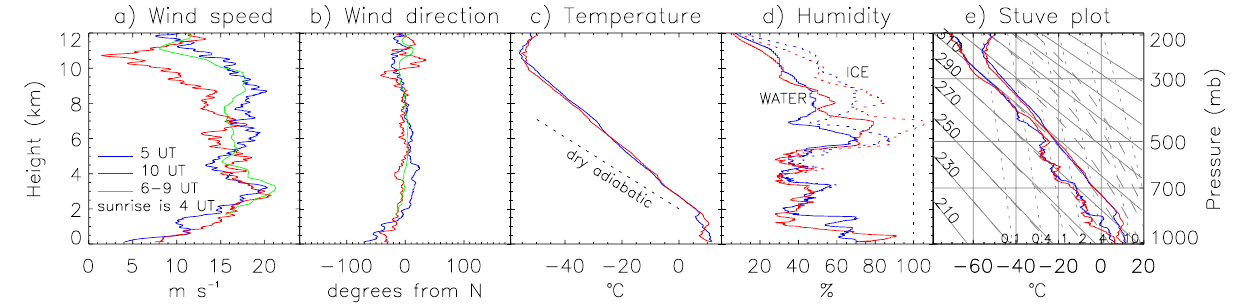
Fig. 3. Radiosonde profiles showing horizontal wind, temperature and humidity, a few hours before and after the time of Fig. 2. Blue and red lines are measured at 05:00 and 10:00UT, respectively; green lines are by VHF radar averaged 05:50–09:00UT. In (c) , there is a marked variation in boundary-layer structure. The dotted line shows dry-adiabatic lapse rate. In (d) , dotted lines show humidity relative to ice, for temperatures below 0 ◦ C. The air is almost saturated relative to ice at a height of roughly 7km. In (e) , diagonal solid, dashed and dotted lines show dry adiabats (K), saturated adiabats, and saturated specific humidity (g/kg). Radiosondes were launched about 80km south of label 5 in Fig. 2a.